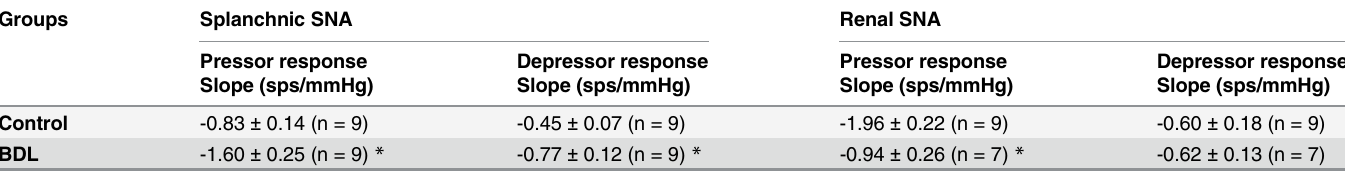
Table 4. Slope values obtained from the linear regression lines in the groups